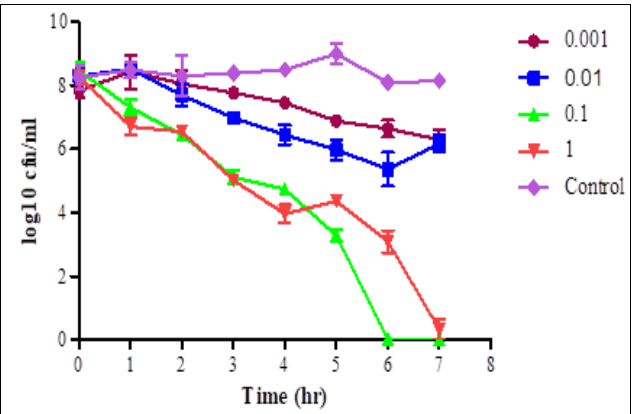
Figure 3. Lytic activity of STEC P2 after infection of STEC O157:H7 wild type strain 93111 at MOI of 1, 0.1, 0.01 and 0.001 for 7 h. LSD value at 0.05: 0.7.